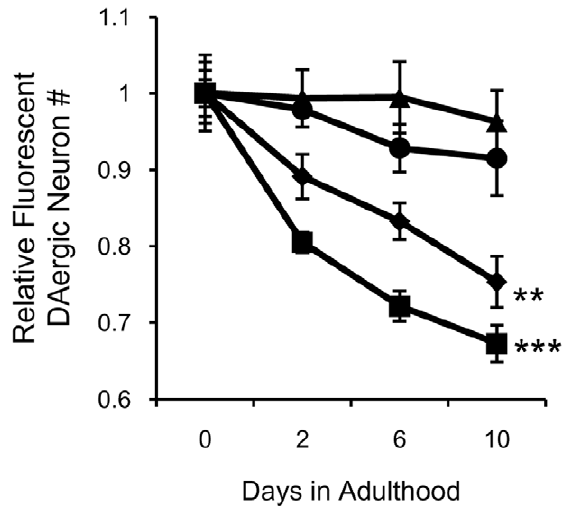
Figure 5. Knockout of TH protects DAergic neurons from h a Syn expression toxicity. A. Quantification of fluorescent DAergic neurons in h a Syn expressing wild type (squares) or h a Syn expressing TH/CAT-2 KO (diamonds) worms and in control wild type (triangles) or TH/CAT-2 KO (circles) worms. Error bars represent the SEM of three independent experiments. **, p , 0.01; ***, p , 0.005 (Two-way ANOVA). In each experiment, n of each sample varied from 10 to 30.